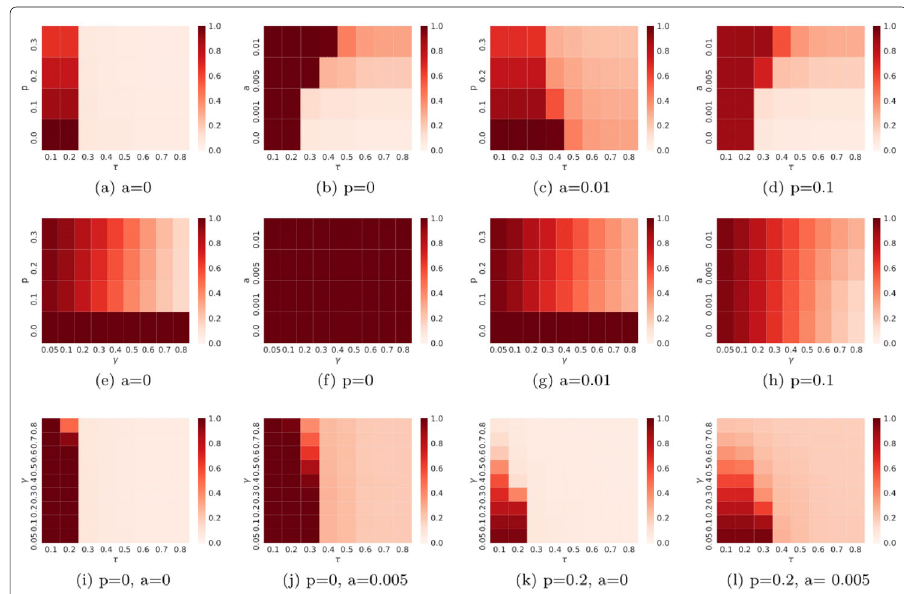
Fig. 5 Heatmap for the Facebook graph. Heatmap for the Facebook network of the percentage of infected nodes at the end of the observed period in the static case. In the first row the results obtained with the Threshold model; in the x-axis we have the τ parameter and in the y-axis the spontaneous adoption rate a , for ( b ) and ( d ) and the immunization probability p for ( a ) and ( c ). In the center row the results obtained with the Profile model; in the x-axis we have the γ parameter and in the y-axis the spontaneous adoption rate a , for ( f ) and ( h ) and the immunization probability p for ( e ) and ( g ).Finally, in the bottom row the results obtained with the ProfileThreshold model; in the x-axis we have the τ parameter and in the y-axis the γ parameter. In this case, for each heatmap we fix at the same time the values of spontaneous adoption rate a and for the immunization probability p as reported in the captions ( i – l )